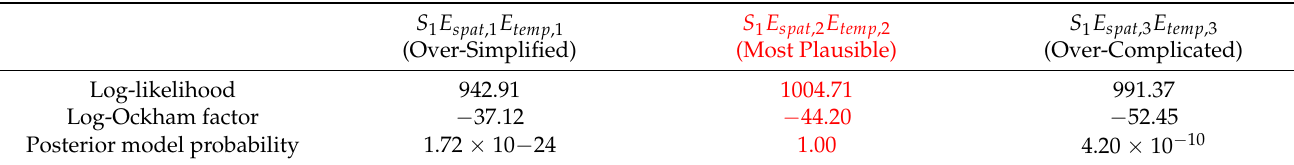
Table 2. Model class selection results (no damage